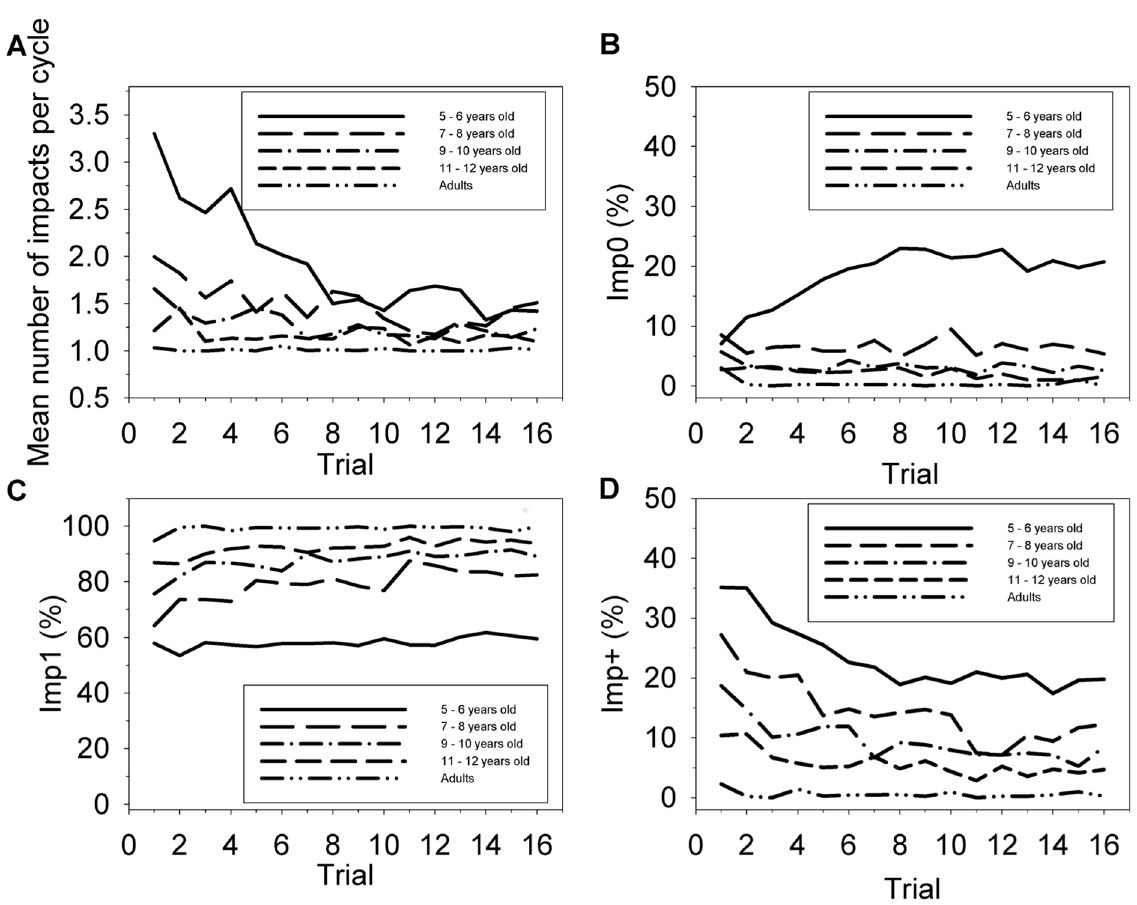
Figure 3. Ball-racket impact. Top-left. Mean number of impacts per racket cycle ( Mean_Imp ) Top-right. Mean percentage of cycles with 1 impact ( Imp1 ); Bottom-left. Mean percentage of cycles with 0 impact ( Imp0 ); Bottom-right. Mean percentage of cycles with more than 1 impact ( Imp + ) . The variables are plotted as a function of the 16 trials for the 5 age groups.